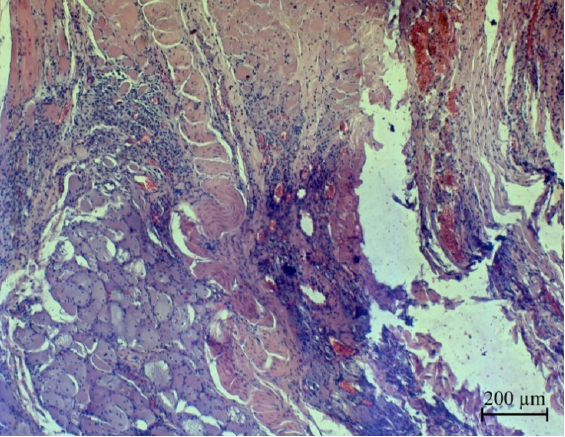
Figure 21. Accumulation of cellular infiltrate under the scab of animals of the first group.